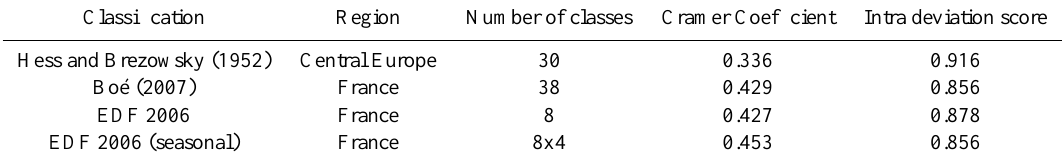
Table 2. Comparison of the discriminating power of three classifications (average of statistics made on 54 rainfall